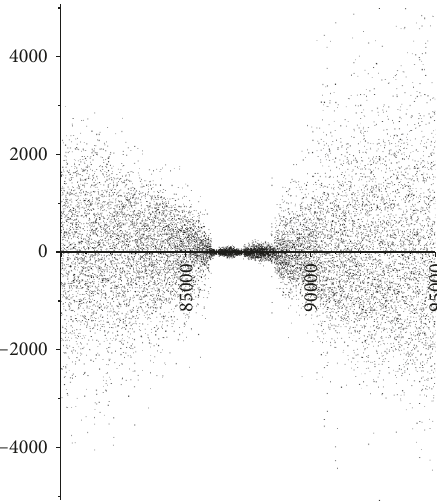
Table 6: The values of 𝛼(𝑘,𝑆 𝑏 (𝑛)) , 𝛼(𝑘,𝐵(𝑛)) , 𝛼(𝑘, 𝐻 𝑏 (𝑛)) , and 𝛽(𝑘,𝐵(𝑛),𝑆 (𝑛)) for the generations of the 𝑄 𝑏